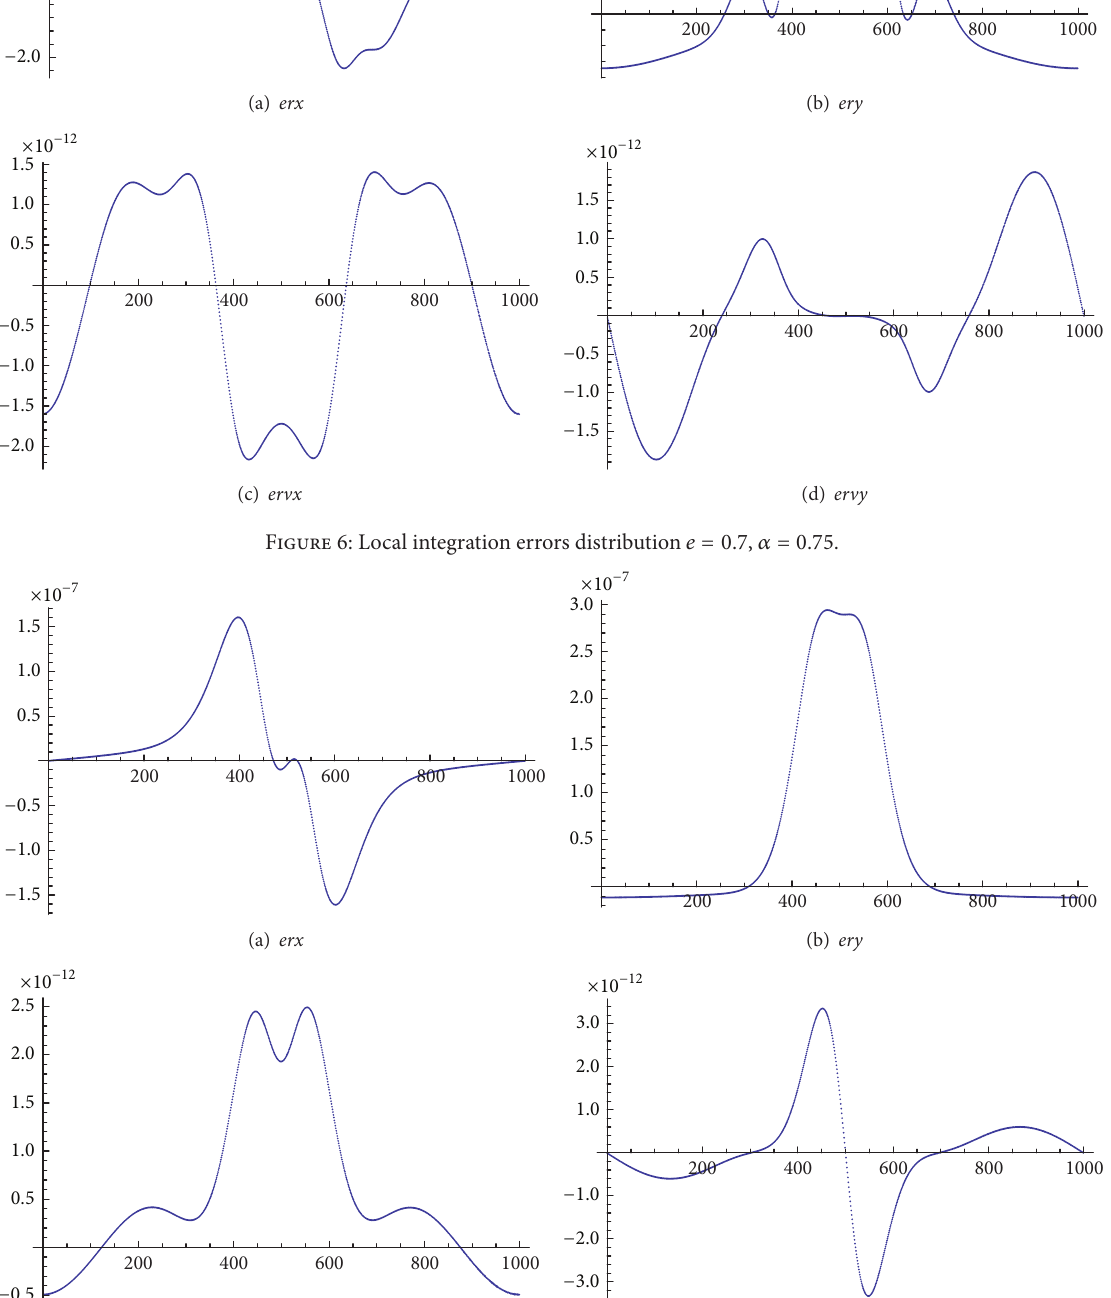
Figure 7: Distribution of the local integration errors 𝑒 = 0.7 , 𝛼 = 1.0